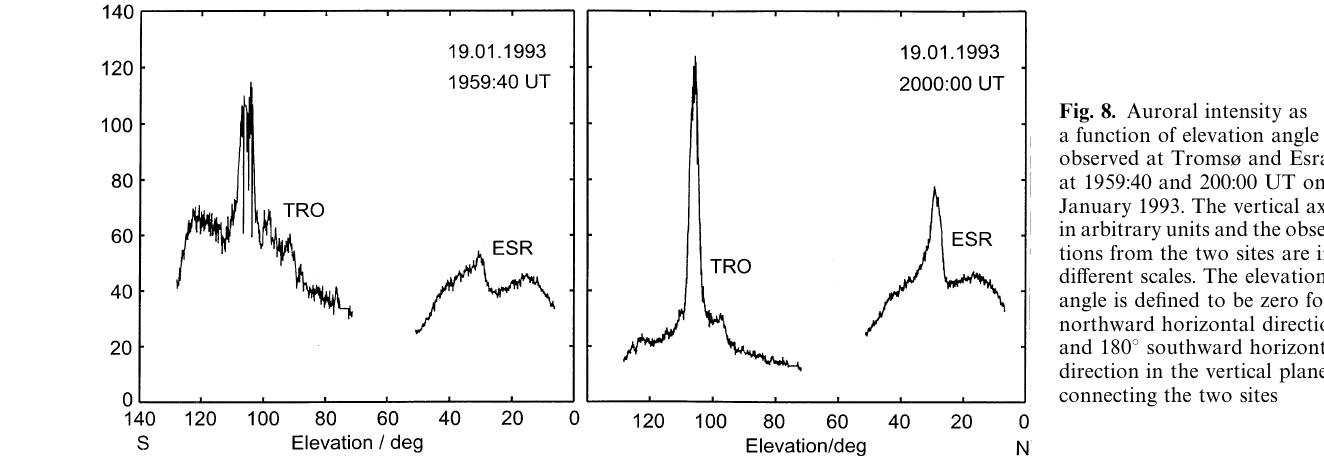
Fig. 7. Same as Fig. 4 for five receivers at 75, 100, 125, 150 and